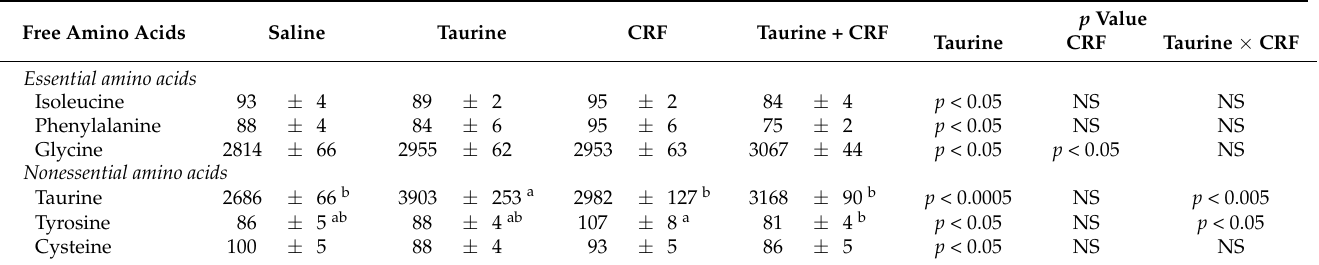
Table 2. Effect of the intracerebroventricular injection of taurine or CRF on amino acid concentrations in the brainstem of chicks exposed to social isolation